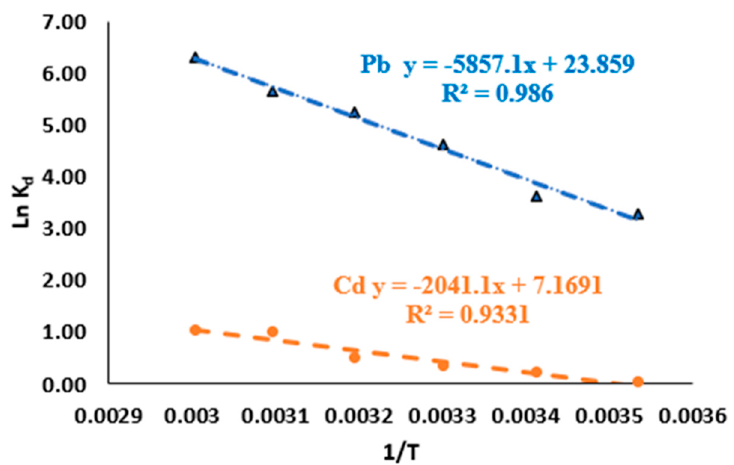
Figure 10. The impact of temperature on of Pb 2+ and Cd 2+ adsorption onto ZnO-NPs.